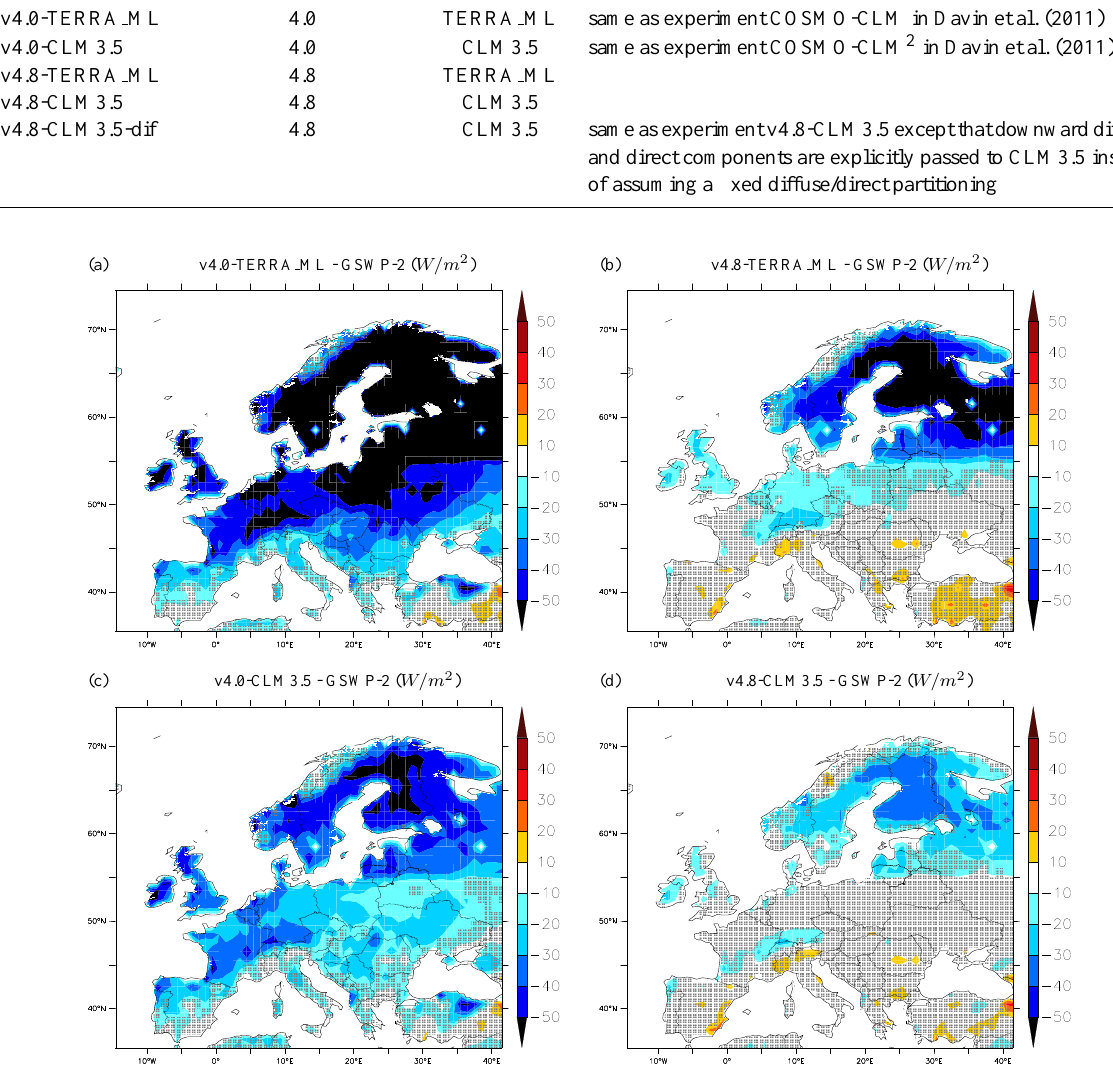
Fig. 1. Summer (JJA) mean net shortwave radiation bias (model minus GSWP-2) for the different experiments. The considered time period is 1986-1995 and areas where the model bias is within the GSWP-2 uncertainty range are indicated with grey shading. Table 1. Summary of the different experiments analysed in this study